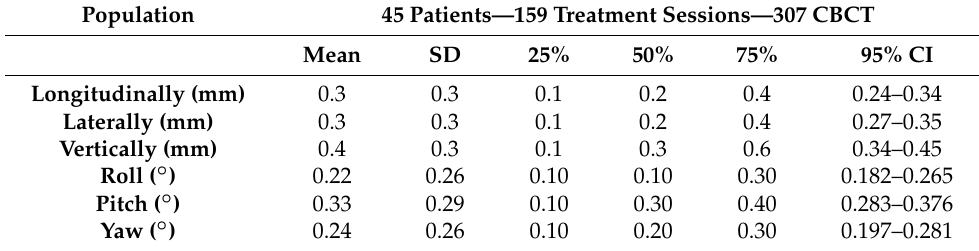
Table 3. Intrafraction main summary statistical